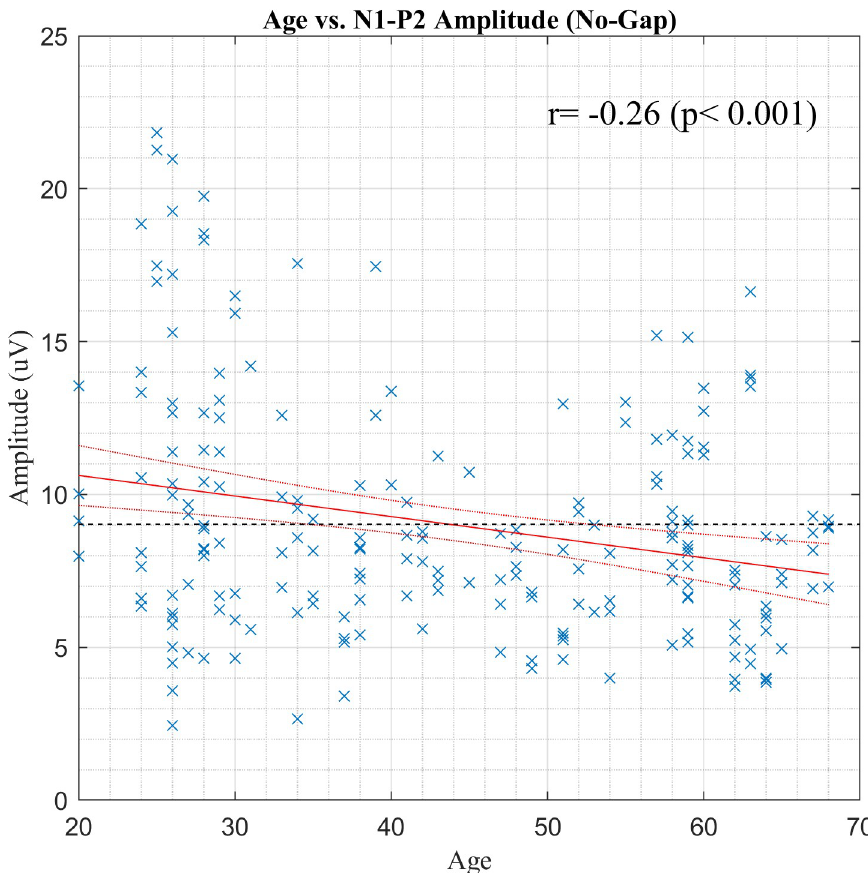
Fig 6. A scatter plot of age versus N1-P2 amplitudes in response to no-gap-intense sound stimuli in the test and retest sessions. The red solid and dotted lines indicate the fitting line and 95% confidence intervals, respectively, based on linear regression analysis. The black dotted line indicates the average of all N1-P2 amplitudes in response to no-gap- intense sound stimuli